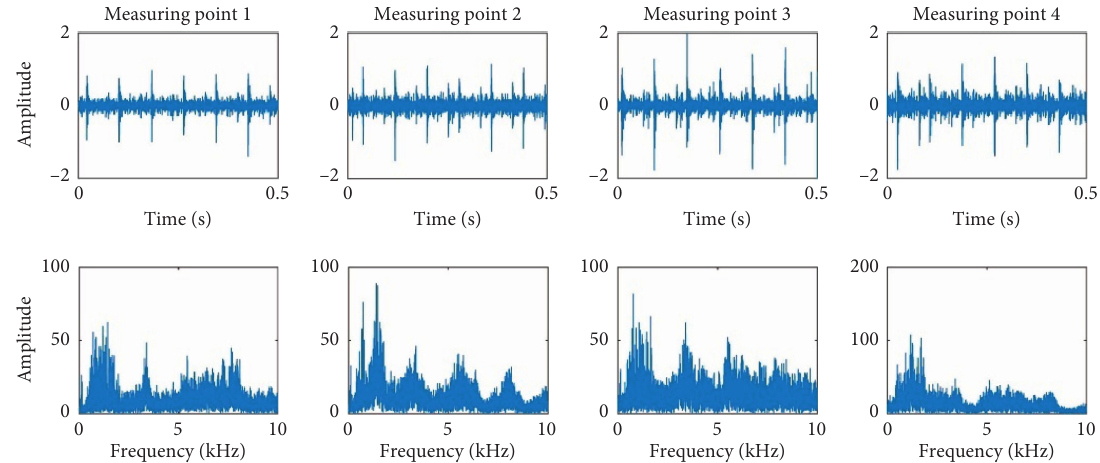
Figure 9: The waveforms of original signals under normal state (time domain and frequency domain).